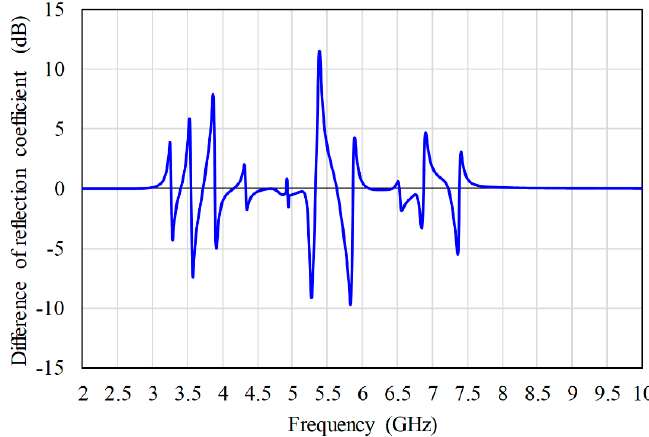
Figure 8. Amplitude di ff erence between vertically and horizontally polarized S 11 for code Figure 8. Amplitude difference between vertically and horizontally polarized S 11 for code “1111111111”. Figure 8. Amplitude difference between vertically and horizontally polarized S 11 for code “1111111111”. Figure 8. Amplitude difference between vertically and horizontally polarized S 11 for code “1111111111”.